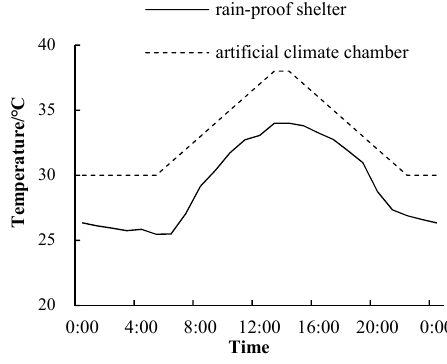
Figure 2. Daily variation of air temperature.